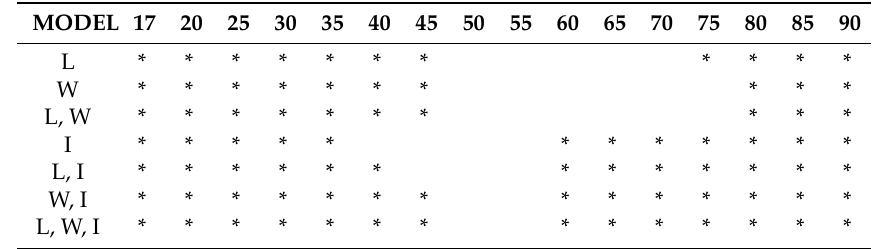
Table 2. 95% confidence limits about the age of a 56-hour-old Chrysomya megacephala larva using the multivariate method of [16]. Training data larvae were reared on pork heart at 25.8 ◦ C and sampled at ages 17, 36, 40, 56, 60, 85, 90 and 96 h [25]. Age prediction models were based on combinations of the two continuous responses—body length (L) and body width (W)—and the categorical response, instar (I). An asterisk indicates rejection of an age (column values), so the prediction interval is shown by the gap in each row. The narrower the interval, the better the model